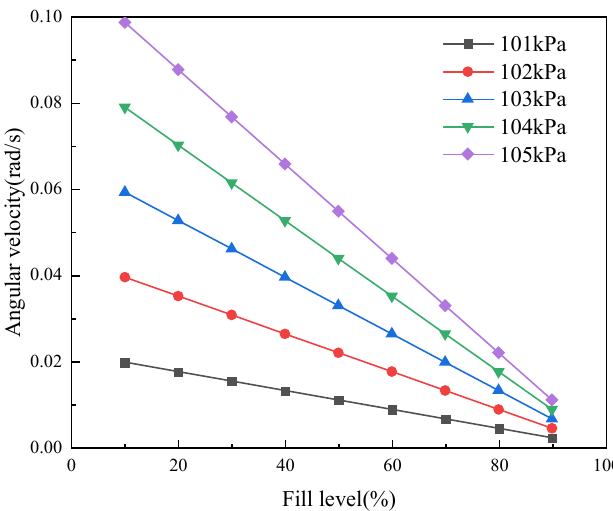
Figure 10. The angular velocity of stable exhaust under di ff erent fi ll levels and pressures.